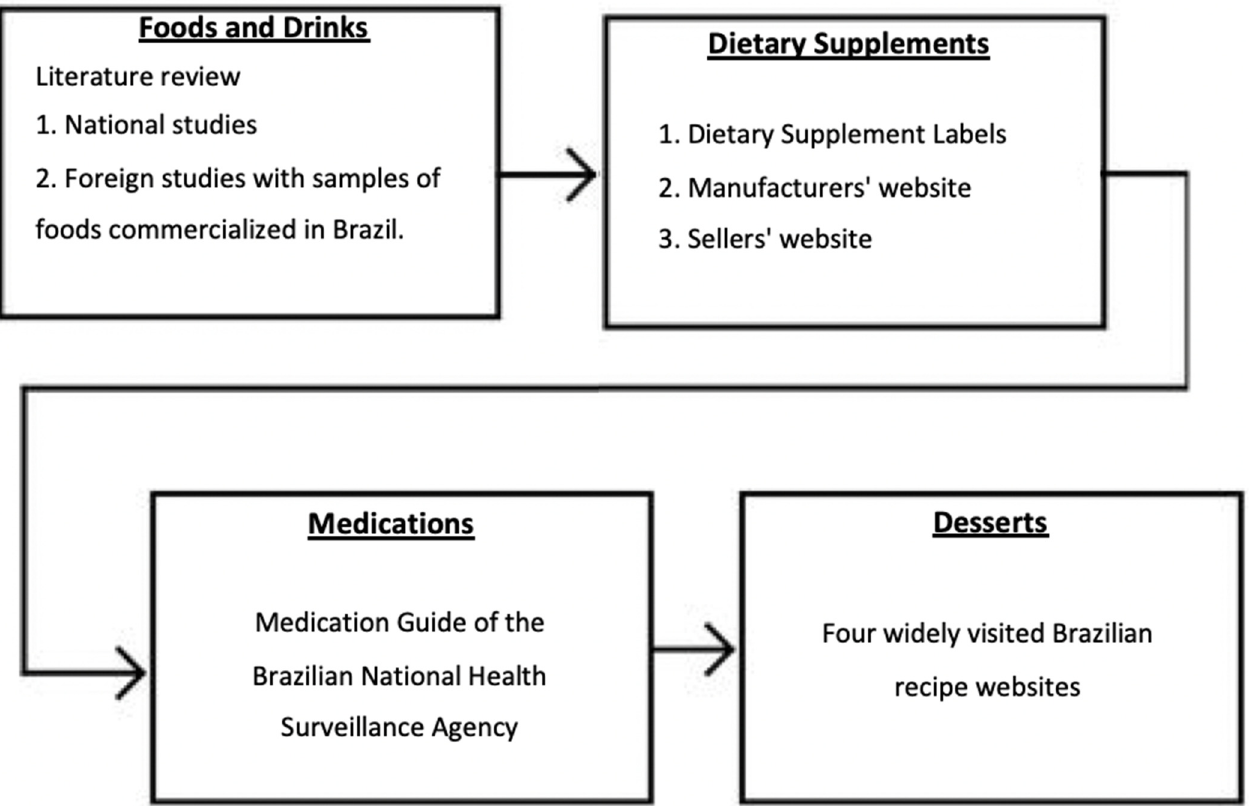
Figure 1. Diagram of databases and priority order to obtain the caffeine contents.